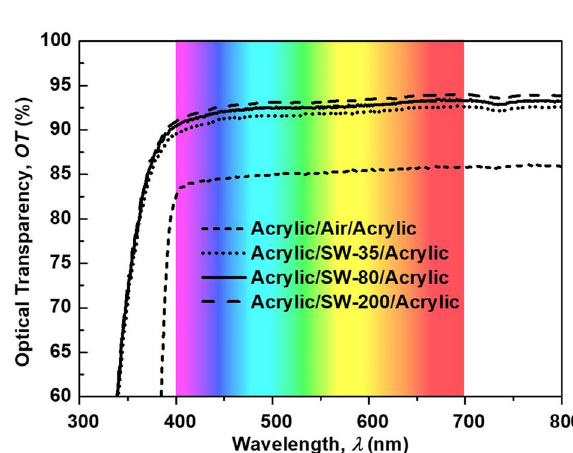
Figure 2. A correct version of the original Figure 4